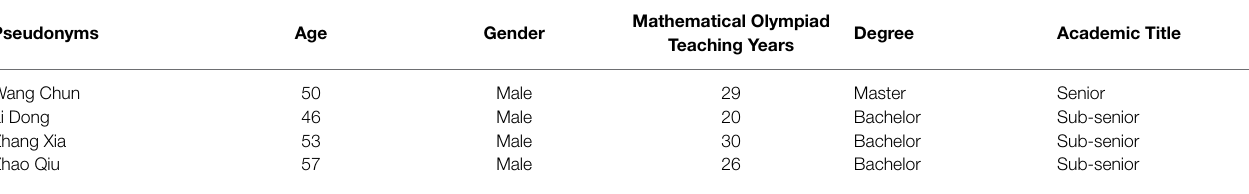
TABLE 2 | Basic information of